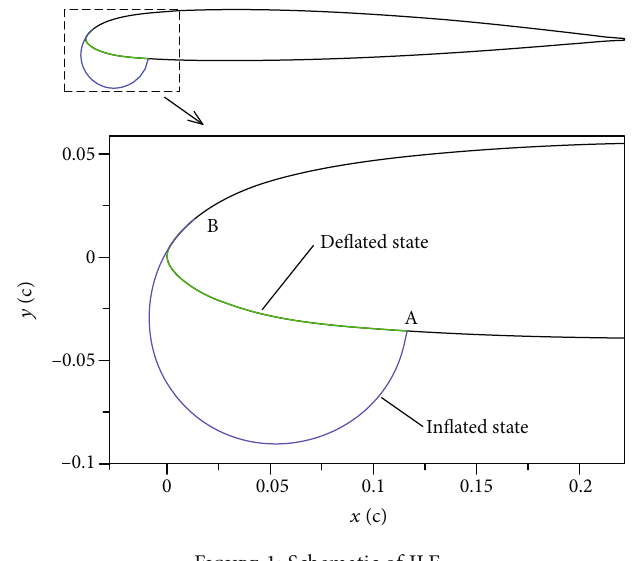
Figure 1: Schematic of ILE.